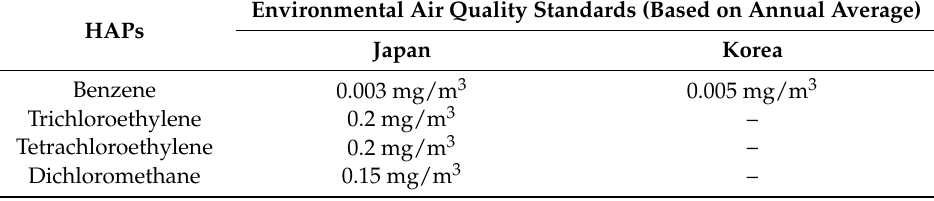
Table 3. Environmental air quality standards for toxic VOCs in Japan and